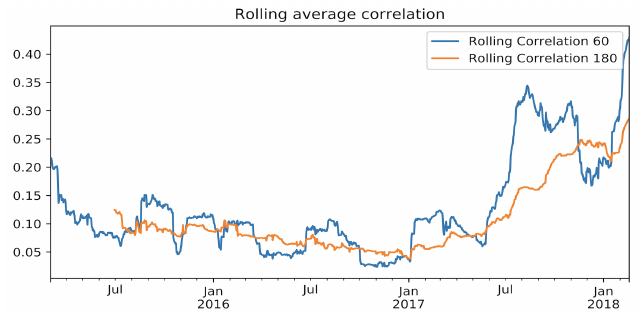
Figure 4: Rolling average correlation (60-days and 180-days, Jan 2015 - Feb